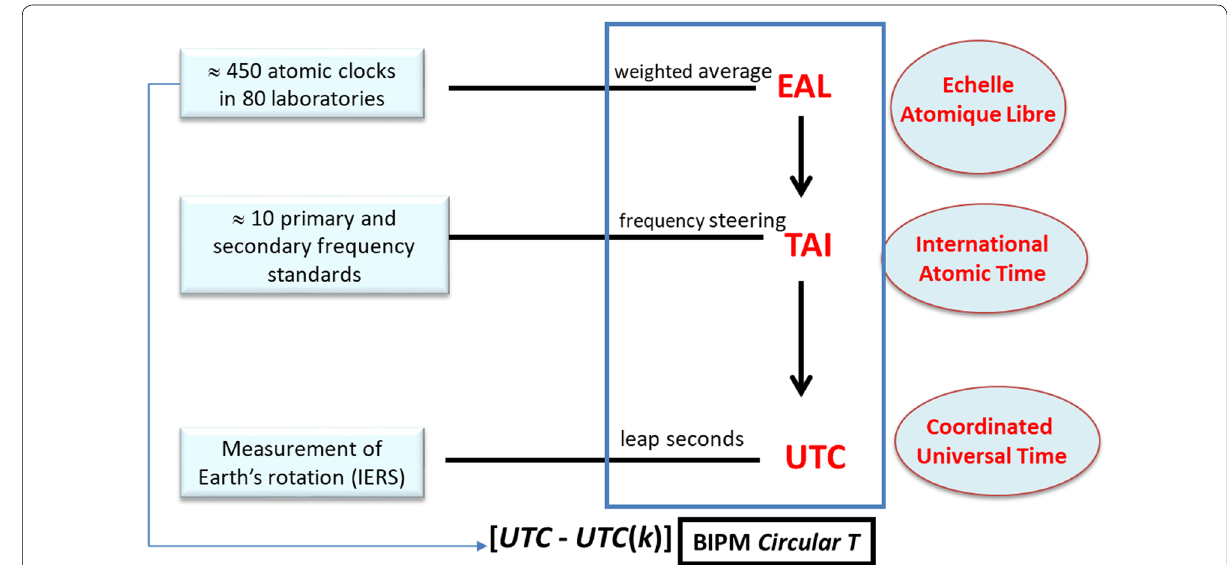
Fig. 2 The computation scheme of UTC (Panfilo and Arias